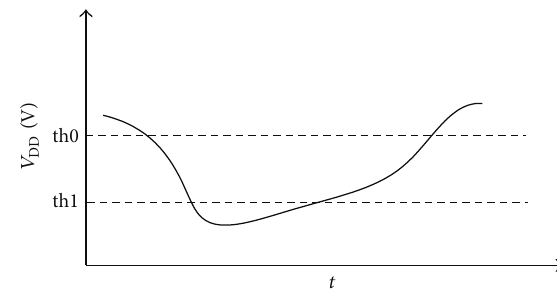
Figure 6: The voltage supply monitor.